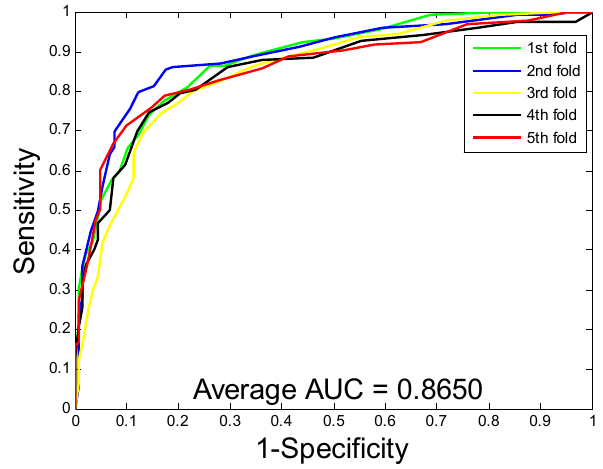
Figure 3. The ROC curves are generated by our method on GPCR dataset.